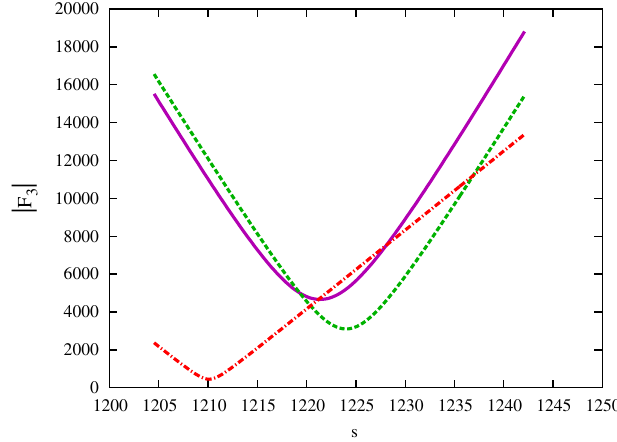
j at 250 GeV in the drift space L232 FIG. 6. (Color) Graph of j F 3 of RHIC for three scenarios: (a) solid (purple)—no rotators; (b) dashed (green)—longitudinal polarization at both STAR and PHENIX; (c) dot-dashed (red)—no rotators at STAR, radial polarization at PHENIX. The horizontal axis shows the arclength in meters, measured from the 6 o’clock point.